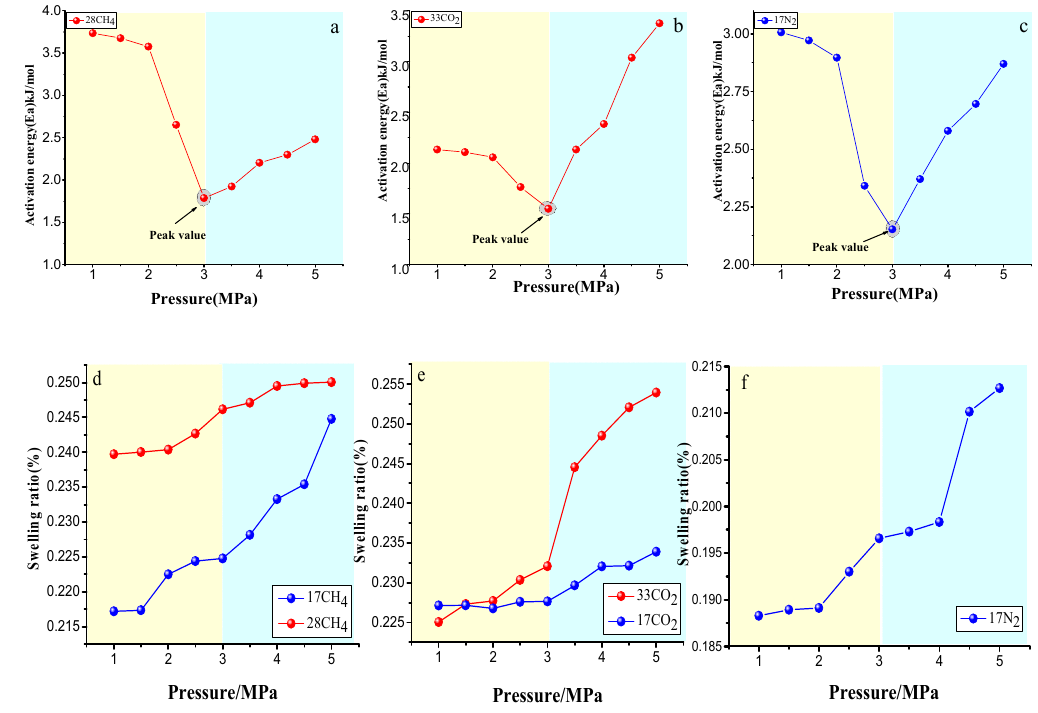
Figure 15. Activation energy of CH 4 ( a ), CO 2 ( b ), and N 2 ( c ) diffusing in vitrinite macromolecules, and the swelling ratio of CH 4 ( d ), CO 2 ( e ), and N 2 ( f ) diffusing in vitrinite macromolecules.5. Conclusions Based on the molecular structure model of TL-1 vitrinite, the self-diffusion and transport diffusion coefficients of CO 2 , CH 4 , and N 2 were obtained by the Monte Carlo method and molecular dynamics simulation. The effects of the gas concentration, temperature, and pressure were examined.